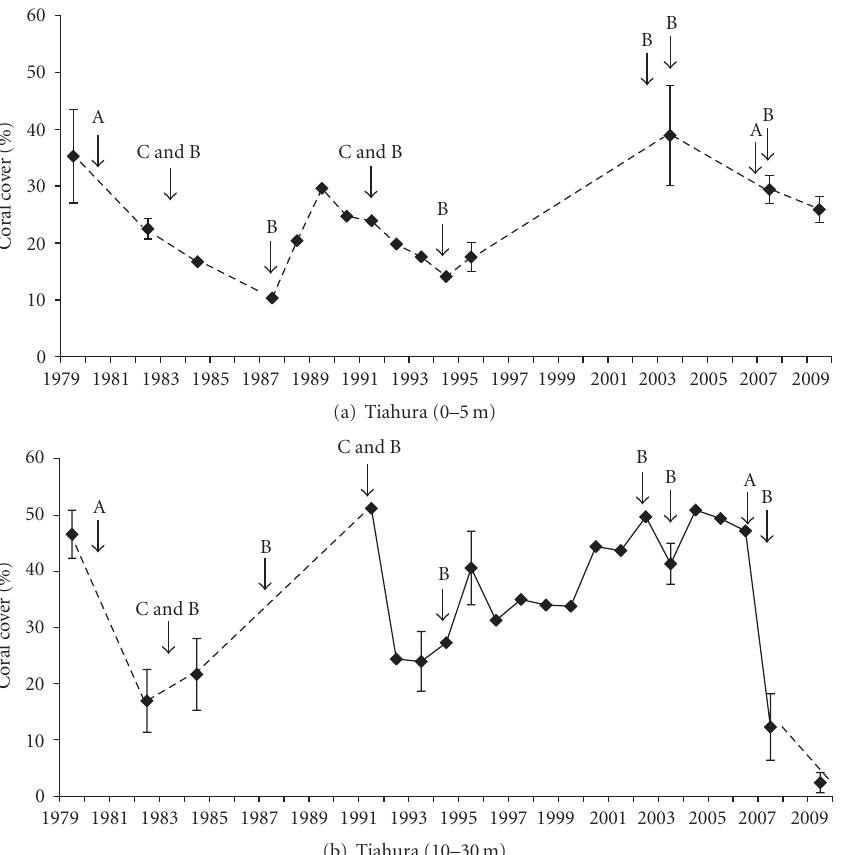
Figure 2: Interannual variation in mean ( ± SE) coral cover in (a) shallowhabitats (0–5m), and (b) deep habitat (0–30m), and at the Tiahura reef, Moorea. Dashed lines indicate presumed trend across years for which no survey data are available. The occurrence of outbreaks of A. planci (A), coral bleaching (B), and cyclones (C) is